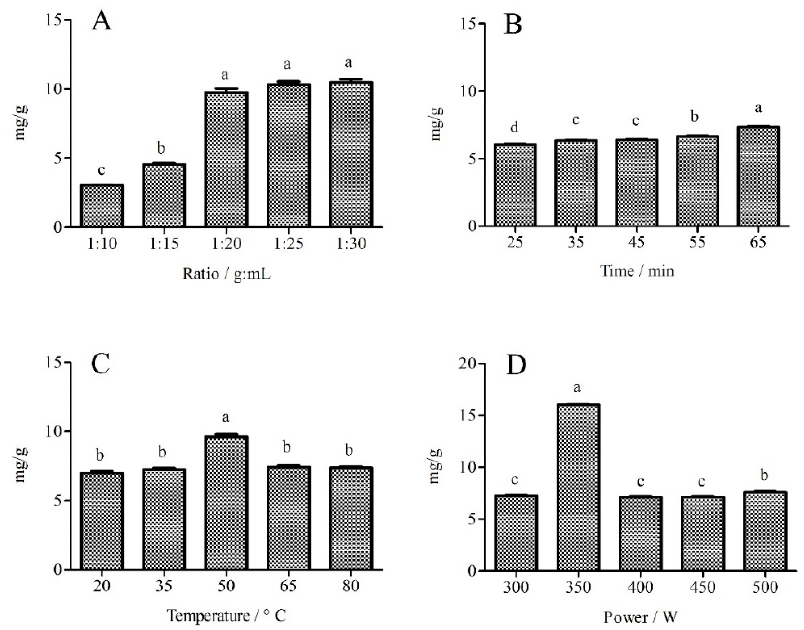
Figure 2. Optimization of the extraction conditions assisted with ultrasound. Results using: ( A ) solid/liquid ratios (g/mL) from 1:10 to 1:30; ( B ) extraction times from 25 to 65 min; ( C ) temperatures from 25 to 80 °C; and ( D ) ultrasound power from 300 to 500 W. Means indicated by different letters differed significantly with a value of p < 0.01.